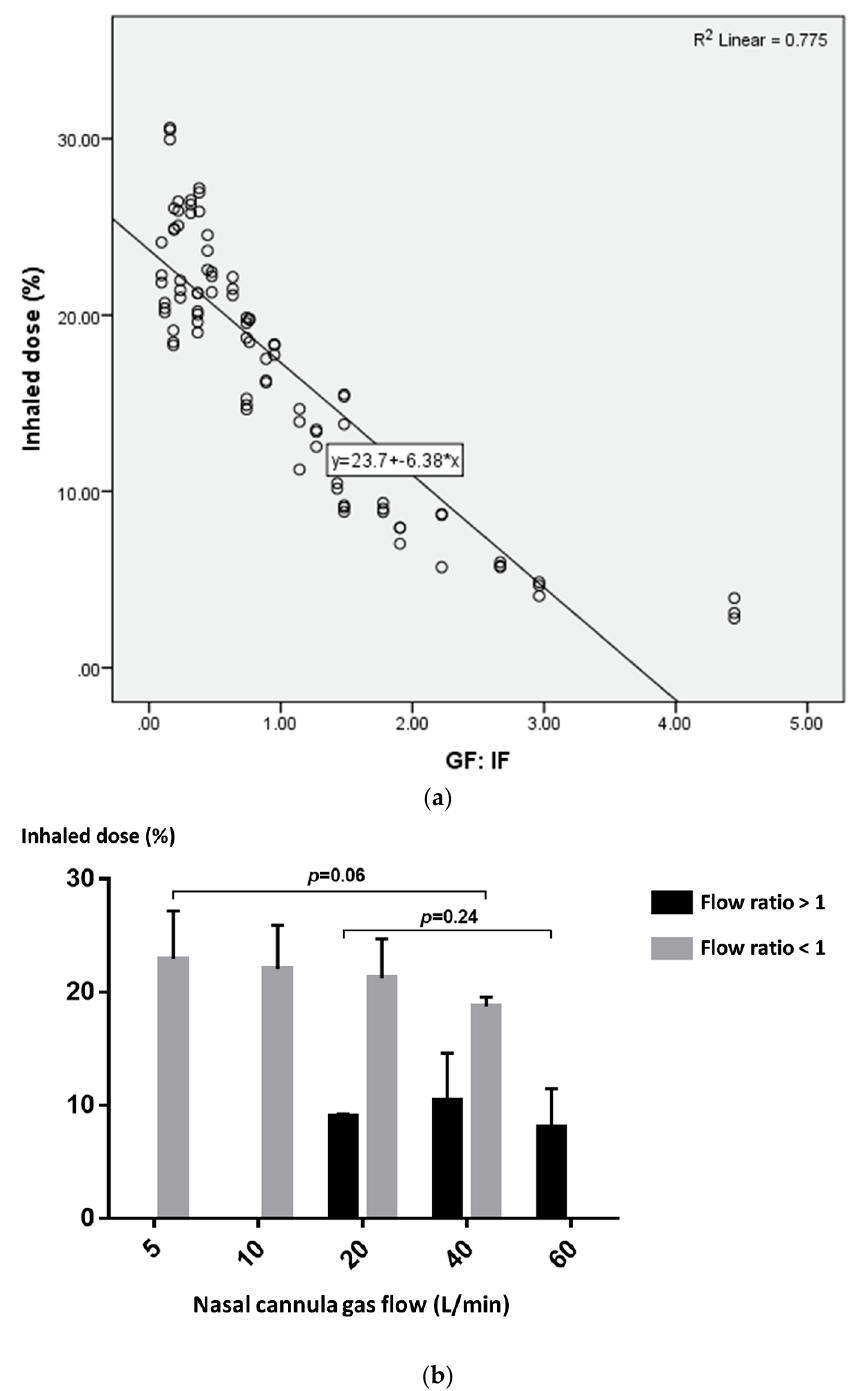
Figure 4. ( a ) Scatterplot of the inhaled dose and the GF:IF ratio; ( b ) inhaled dose with the ratio of GF:IF < 1 and > 1 in different nasal cannula flows.